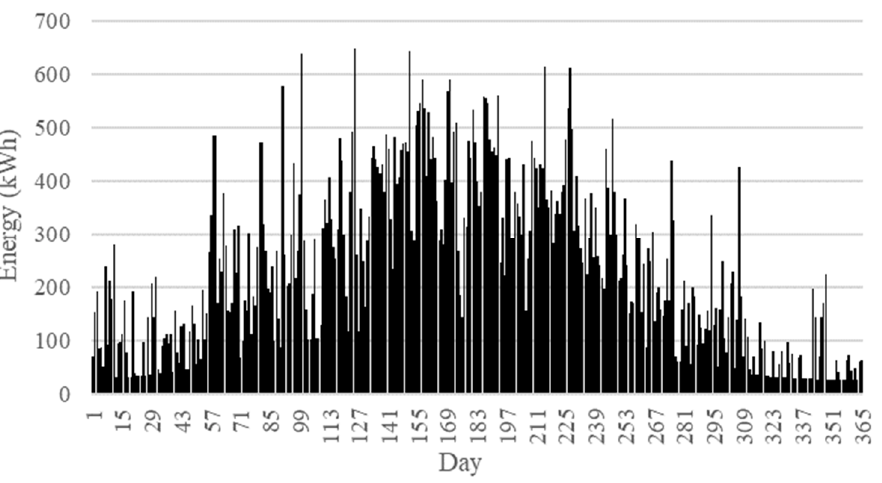
Figure 13. Daily changes of electricity generation of the considered PV system during a whole year.